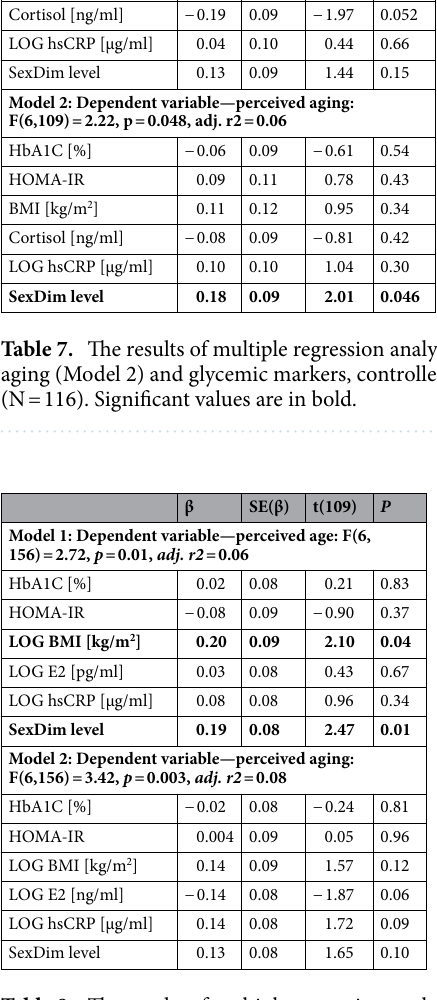
Table 8. The results of multiple regression analysis for the relationship between perceived age (Model1) or aging (Model 2) and glycemic markers, controlled for BMI, estradiol, hsCRP, and facial masculinity in women (N = 163). Significant values are in